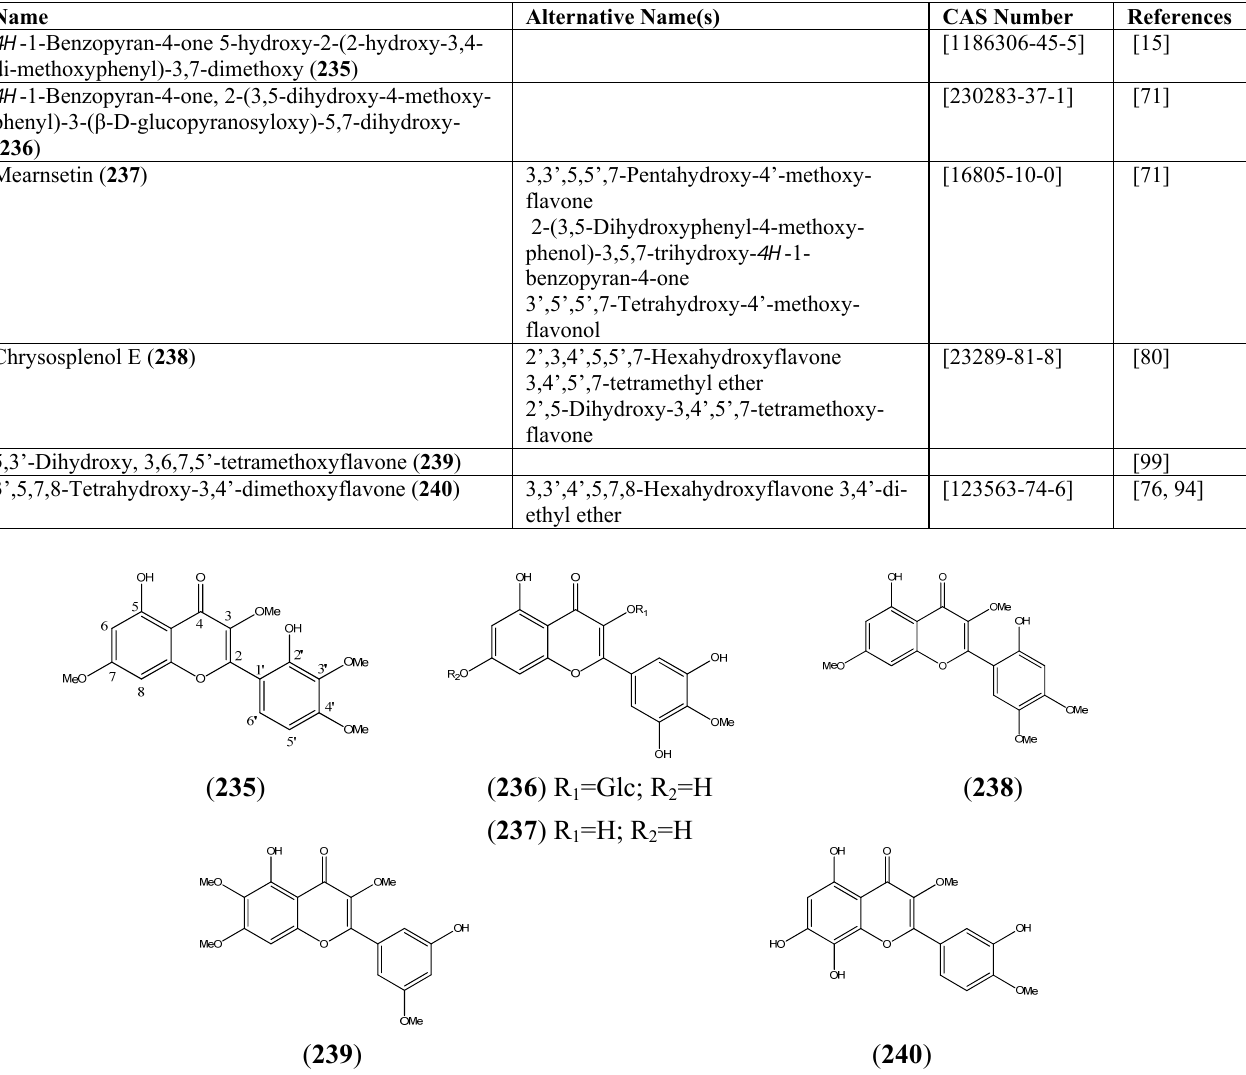
Table 22. Other Hexahydroxy